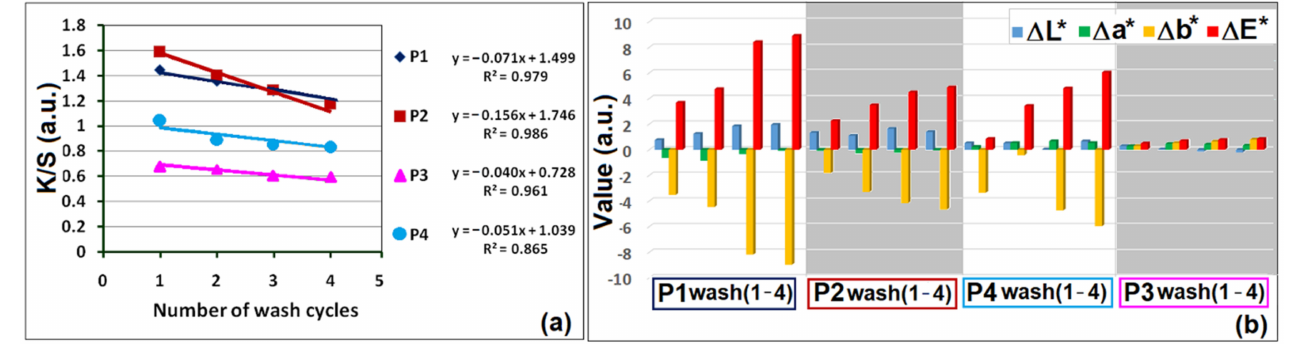
Figure 10. Evaluation of the films’ resistance during repeated washing cycles by the measurement of K/S values ( a ) and ∆ E* in CIEL*a*b* system ( b ).